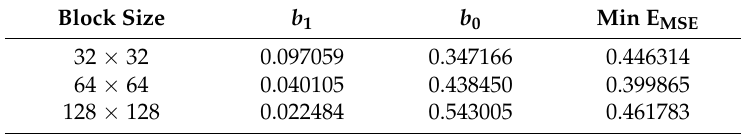
Table 3. The coefficients of the f ( σ , b 0 , b 1 ) function for three different choices of image block size. Block